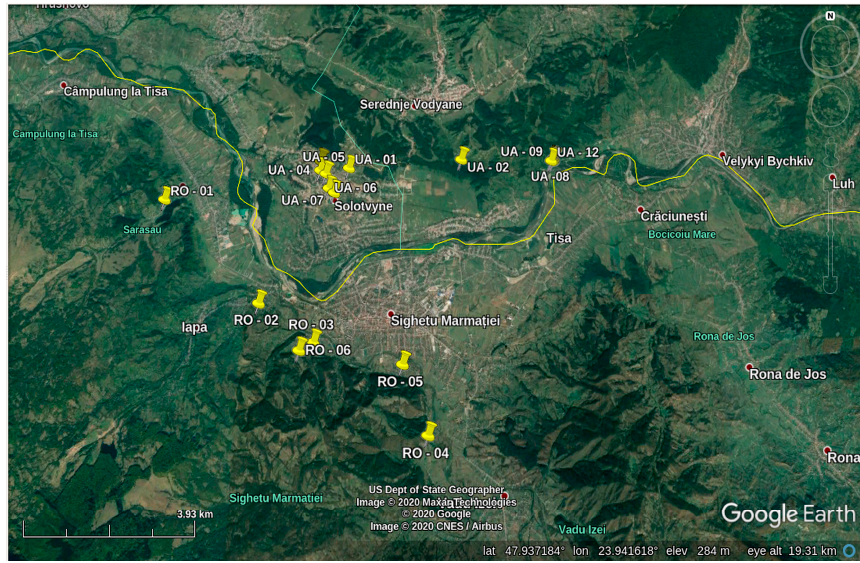
Figure 1. Study area. Source: GeoSES project [41].